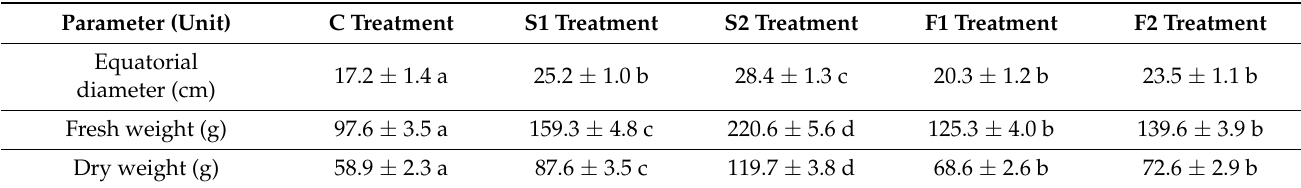
Table 7. Equatorial diameter, fresh weight and dry weight of the tomatoes obtained during the experimental period for each fertilizer